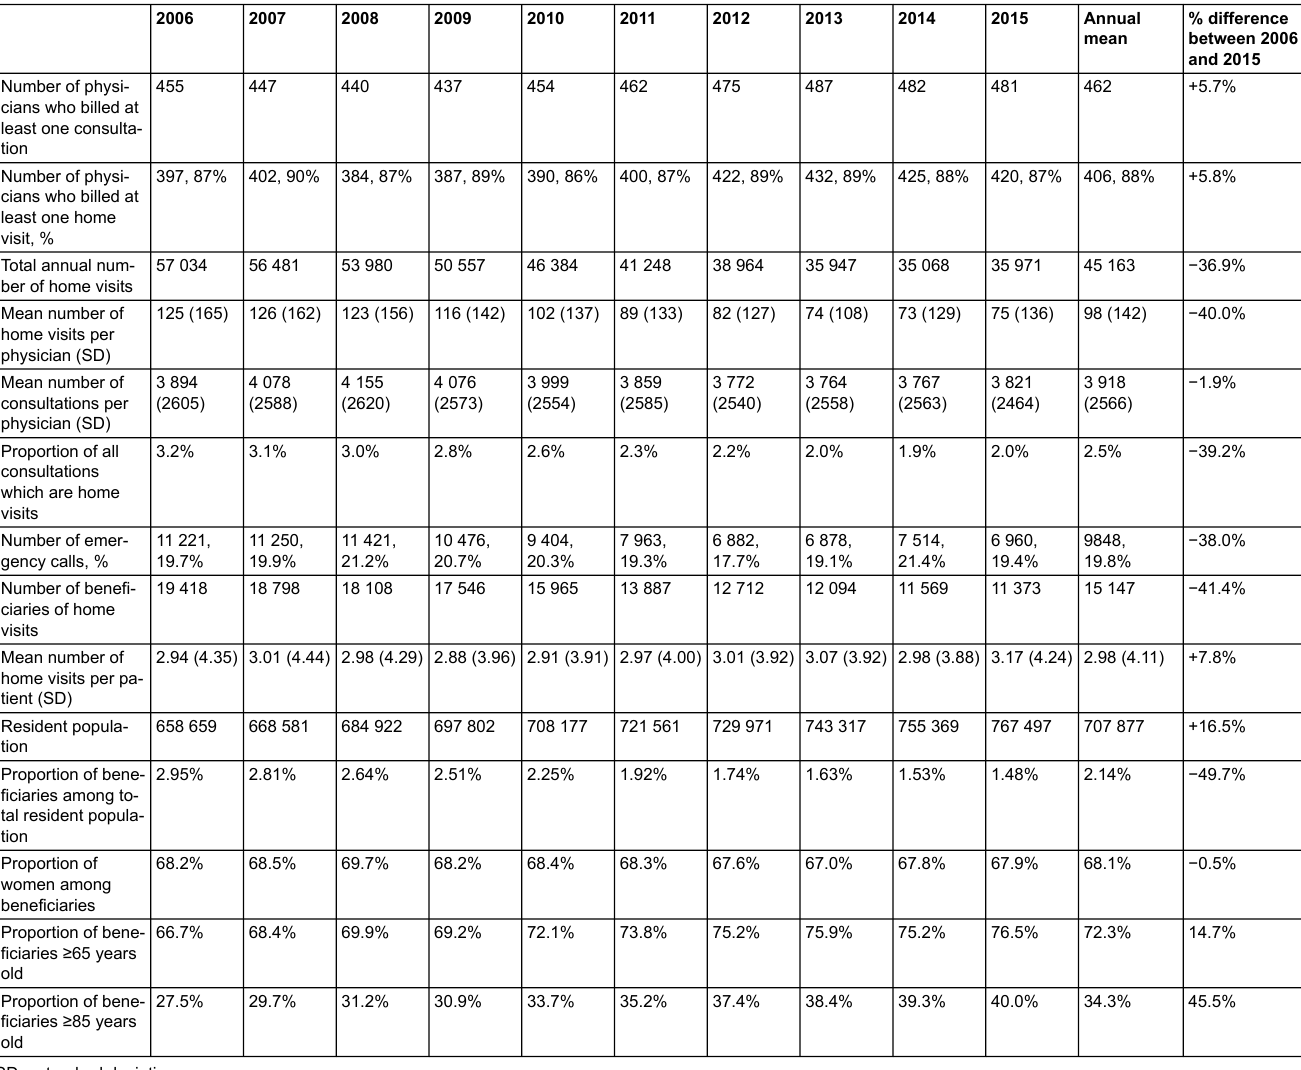
Table 2: Number and characteristics of GP home visits made in the canton of Vaud, Switzerland, by year, and relative difference between 2006 and 2015. 2006